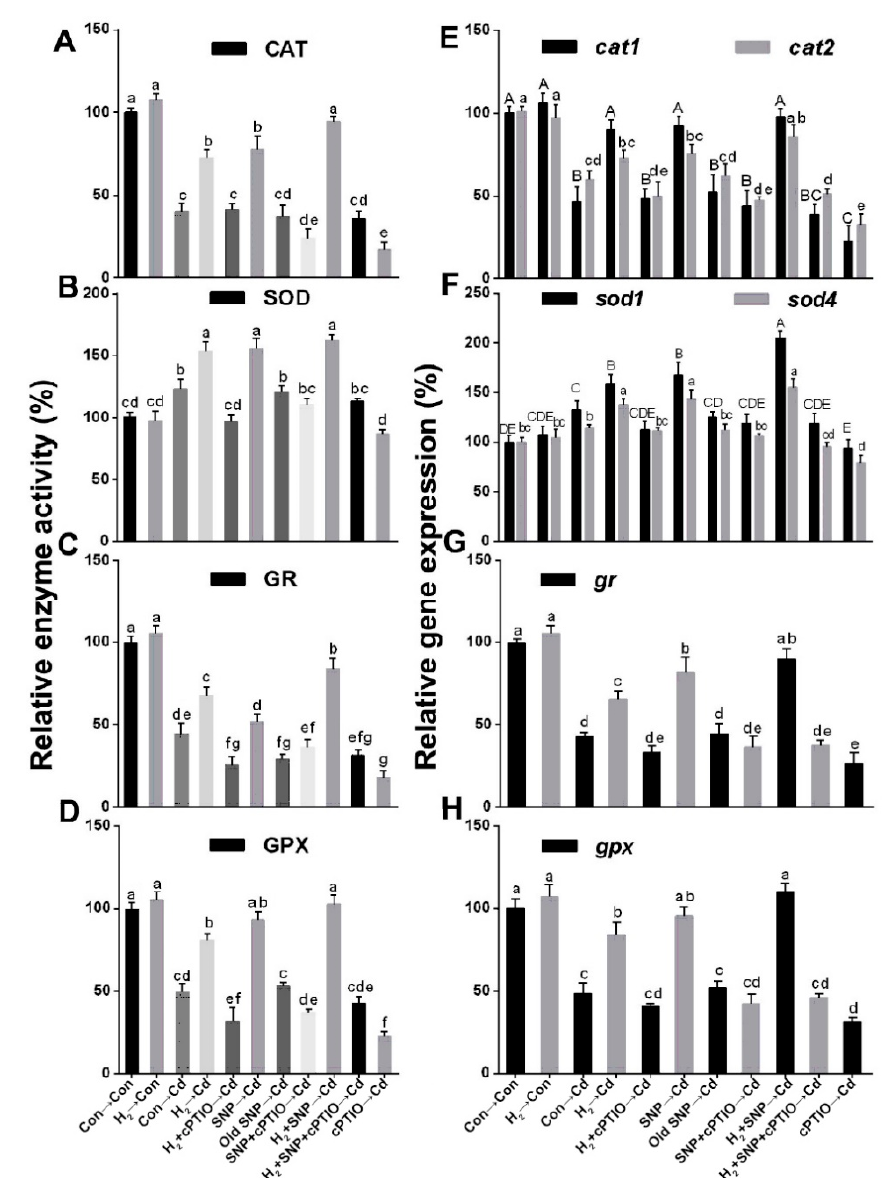
Figure 9. Alterations in the activities of the enzymes CAT, SOD, GR, and GPX and the levels of the corresponding transcripts. Two-day-old mycelia were either pre-treated or not with 3% H 2 for 24 h. Stressed mycelia were either pre-treated or not with 500 µ M SNP, 500 µ M old SNP, or 500 µ M cPTIO for 30 min alone or in the indicated combinations after H 2 pre-treatment. Then, mycelial discs from different treatments were grown on stressed or non-stressed solid CYM for 12 or 24 h, respectively. Enzymes’ activities were detected in the 24 h Cd stressed mycelia ( A – D ). Corresponding transcripts’ levels were also determined in the 12 h stressed mycelia ( E – H ). Mycelia without chemicals were used as the control for each analysis (Con → Con), while H 2 alone treated mycelia were represented as H 2 → Con. Bars with different letters are significantly different at p < 0.05 according to one-way ANOVA with multiple comparison using Tukey’s test.